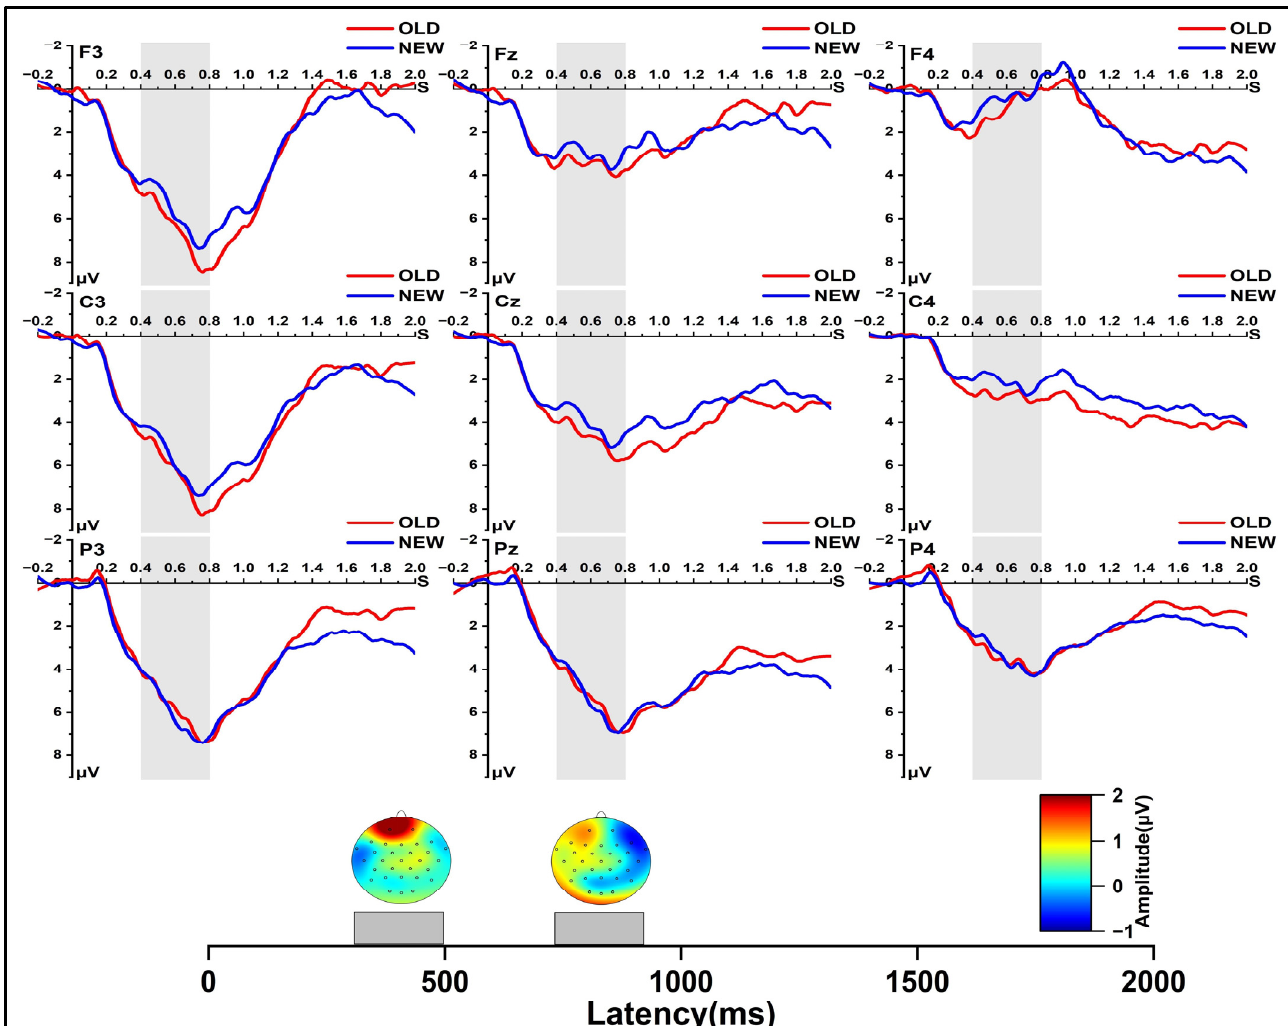
Figure 4. Grand‑average ERPs from all selected channels for Old and New items and spherical‑spline interpolated scalp distributions of the solution type (Old minus New) in 400~500 ms and 700~800 ms time